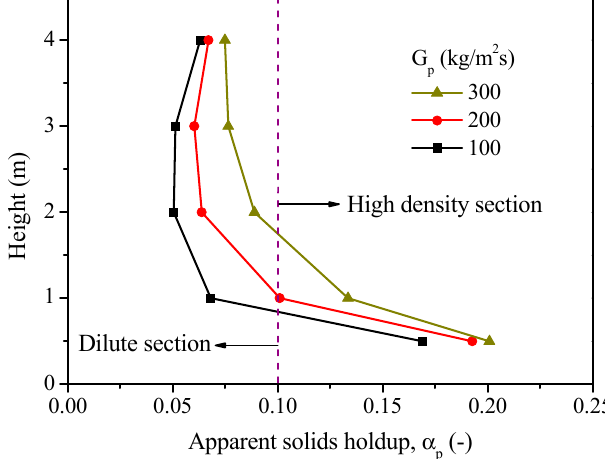
Figure 5. Mean solids holdups in different heights as a function of solids flux.